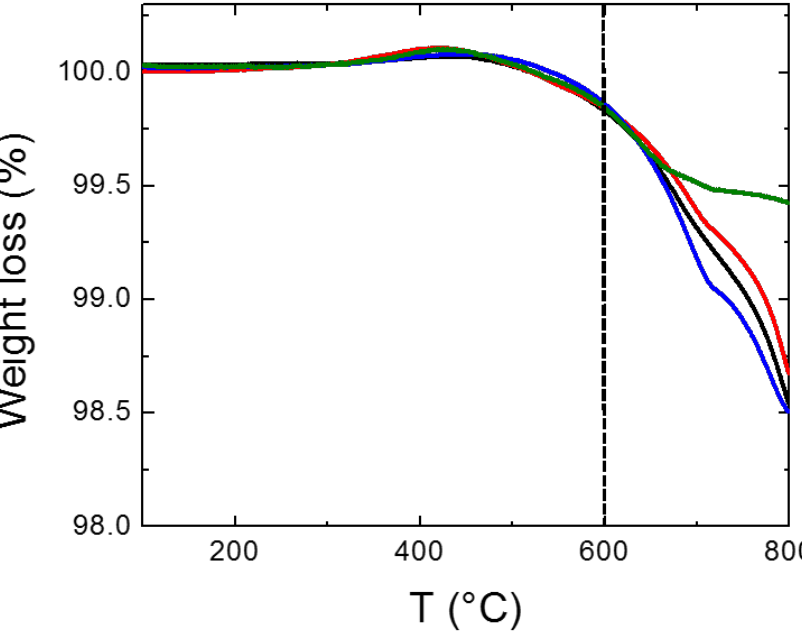
Figure 6. TGA curves measured under nitrogen after steps 4 and 5 (see experimental part, Section 2.2) for BSCF10 (black), BSCF17 (red), BSCF22 (blue) and BSCF31 (green).